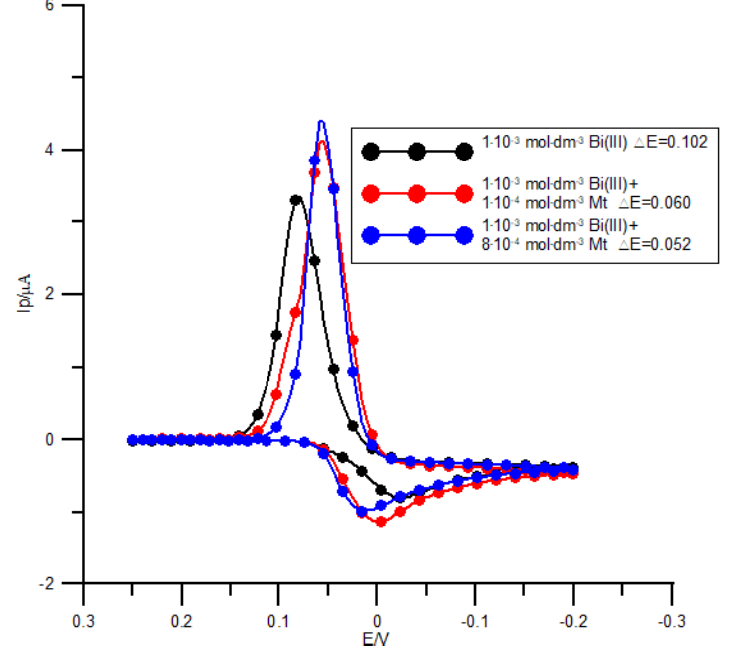
Figure 6. Cyclic voltammograms of 1 × 10 −3 mol dm −3 Bi(III) electroreduction in 1 mol dm −3 chlorate(VII) solution in the presence of methionine. The concentration of methionine, together with the value of the corresponding peak potential separation, is given in the plot. The scan rate was 50 mV s − 1 . Table 1. The peak potential separation Δ E of cyclic voltammograms for the electroreduction of 1 ×